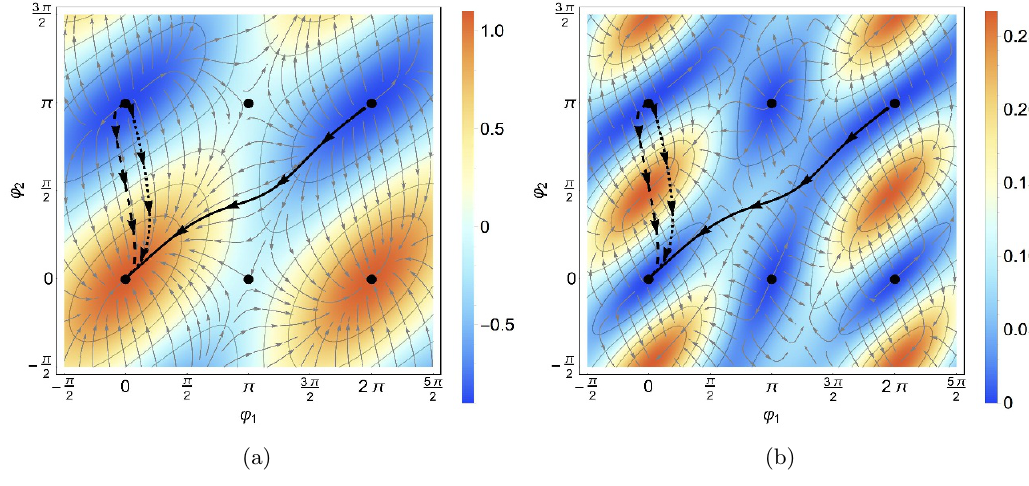
Figure 10 . SU(3) (cid:12)elds | case III (a) pre-potential U and ~ r (cid:17) U (cid:0) (cid:13)ow and (b) potential V and the gradient (cid:13)ow ~ r V . A dotted curve describes the BPS solution obtained for the initial conditions ’ 1 (0) = 0 : 1, ’ 2 (0) = 3 : 1095, a dashed one for ’ 1 (0) = 0 : 1, ’ 2 (0) = 1 : 3 and a solid one for ’ 1 (0) = 2 : 75, ’ 2 (0) = 1 :